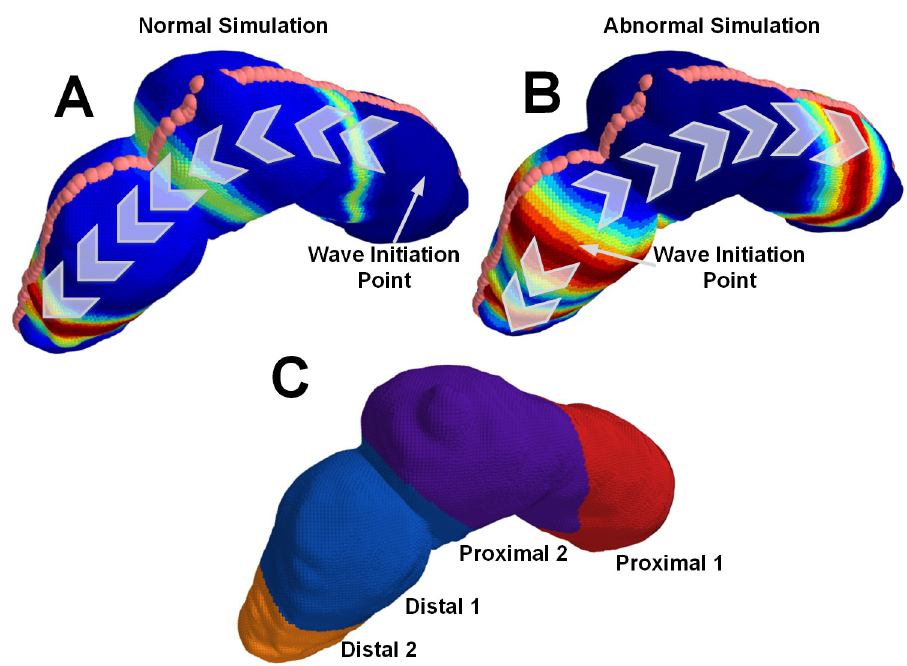
Fig 2. Abnormal and normal simulation propagation directions. A) 3D physiology mapped normal simulation. The wave initiates in the proximal stomach and has only anterograde propagation. B) 3D physiology mapped abnormal simulation. The wave initiates in the distal stomach and has both retrograde and anterograde propagation. C) The different proximal and distal regions of the